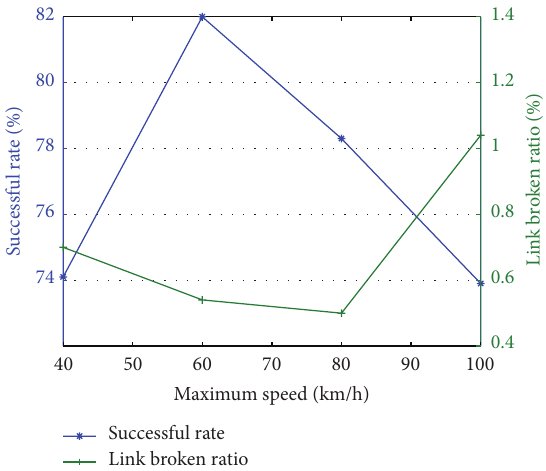
Figure 3: The relation of the maximum speed of taxi nodes and the ratio of passenger node contacting empty taxi nodes successfully.